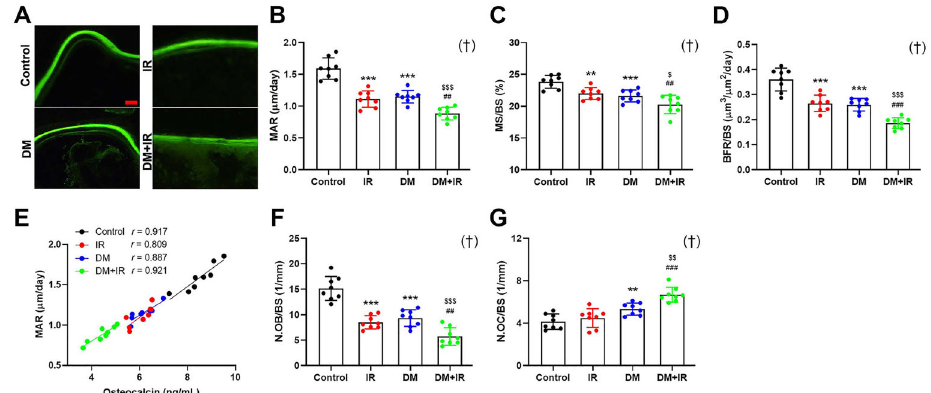
Figure 3. Effects of focal irradiation on bone histological and histomorphometric parameters in streptozotocin-treated diabetic rats or non-diabetic rats. A , Representative calcein double labeling images of the femoral trabecular bone in the Control, irradiation (IR), diabetes mellitus (DM), and DM + IR rats. Scale bar 20 m m. B – D , Quantitative analysis of dynamic histomorphometry for mineral apposition rate (MAR), mineralizing surface per bone surface (MS/BS), and bone formation rate per bone surface (BFR/BS). E , Linear regression analysis of MAR and concentration of osteocalcin in serum. F and G , Static histomorphometric analysis for number of osteoblasts (N.OB/BS) and osteoclasts (N.OC/BS) on femoral trabecular bone in the control, IR, DM, and DM + IR groups. Data are